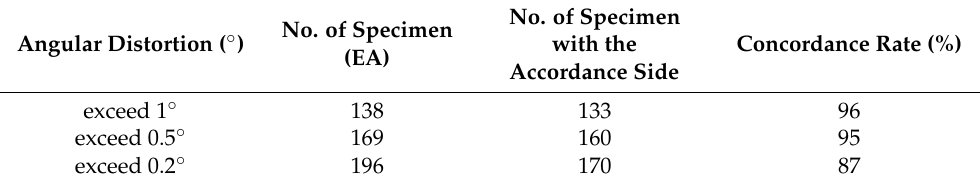
Table 8. Concordance rate of the fractured and acute angle sides. No. of Specimen No. of Specimen with the Concordance Rate (%) Angular Distortion ( ◦ ) (EA) Accordance Side exceed 1 ◦ 138 133 96 exceed 0.5 ◦ 169 160 95 exceed 0.2 ◦ 196 170